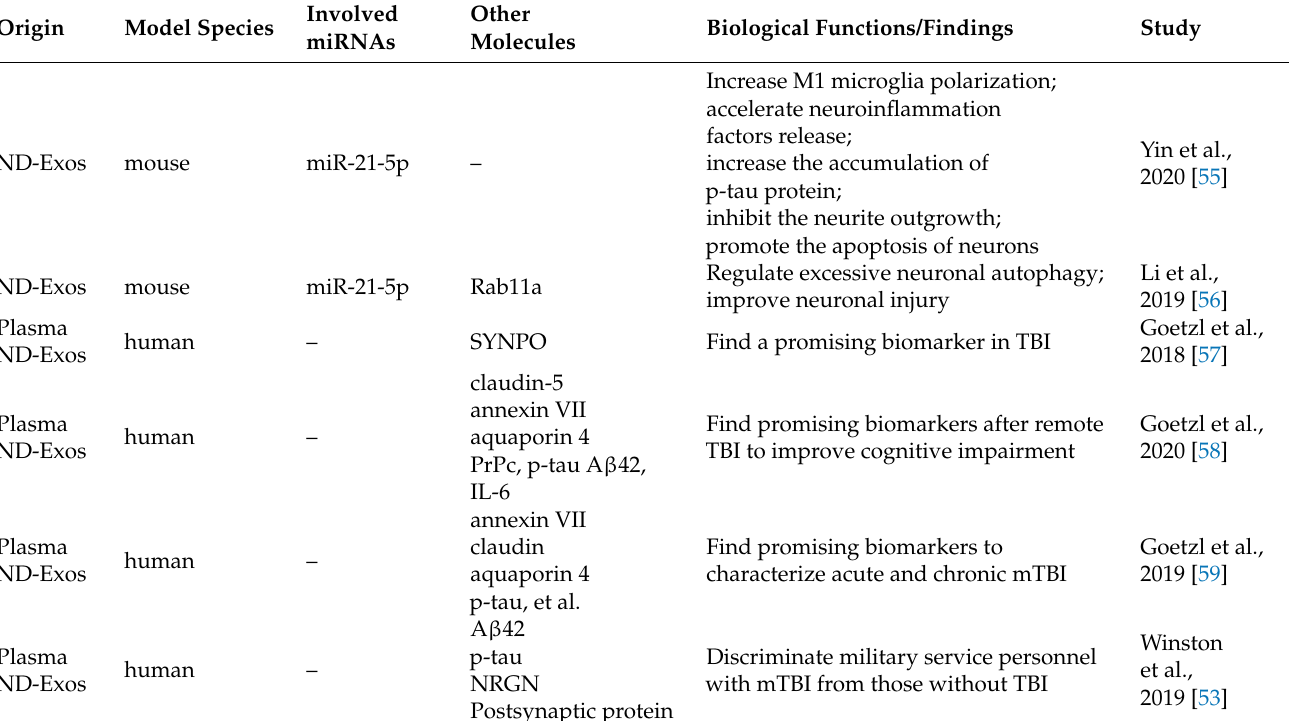
Table 3. Neuron-derived-Exos/EVs and ND-Exos/EVs-miRNAs studies in